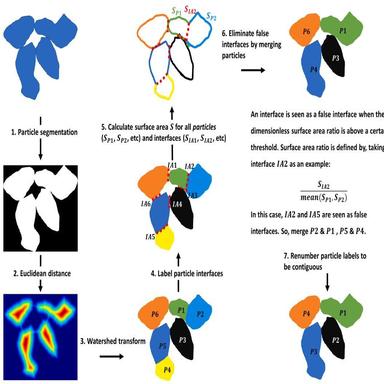
Schematic procedure of the new particle separation method.